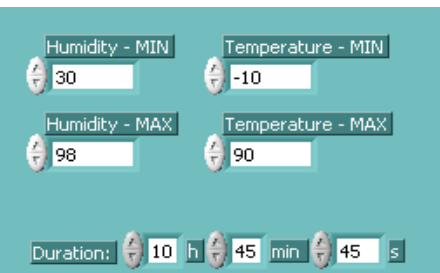
Figure 9. Inserting parameter